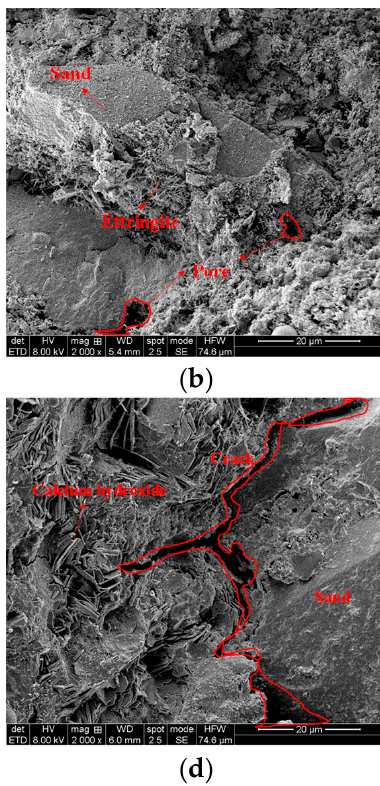
Figure 3. Variation pattern of uniaxial compressive strength versus distance for each test point (the water–cement ratio is 1.0; the fractal dimension of pores is 1.5; temperature is 20 °C).